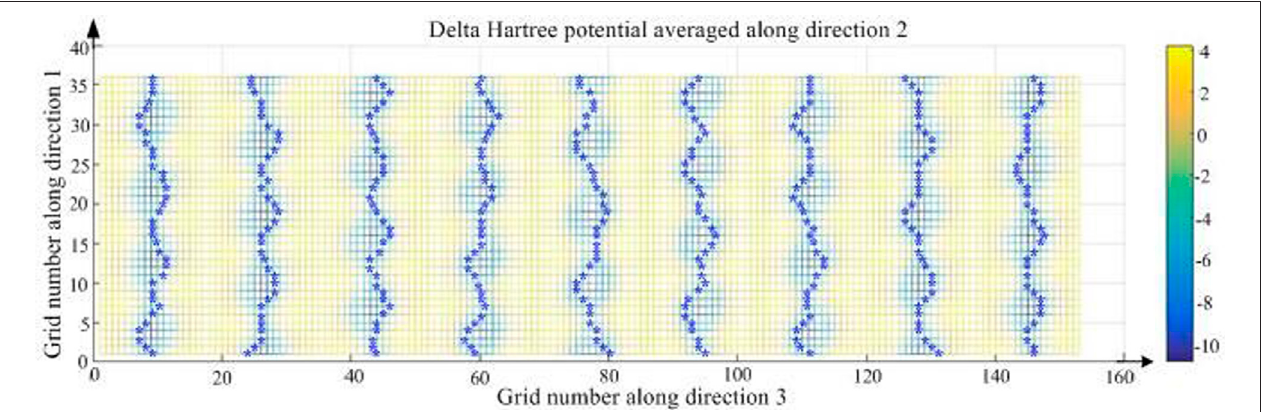
FIGURE 7 | 2D potential energy map of Li 1.1 Na 0.1 Mn 0.54 Ni 0.13 Co 0.13 O 2